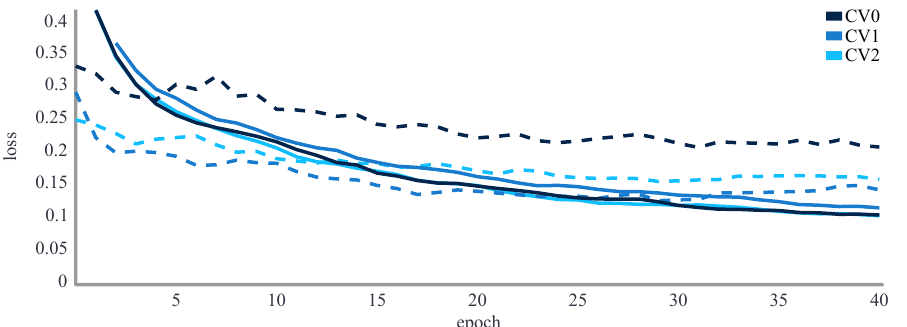
Figure 8. Training loss (solid line) and validation loss (dashed line) of the loss during the 3-fold cross validation to find the optimum hyperparameters. No overfitting observed.